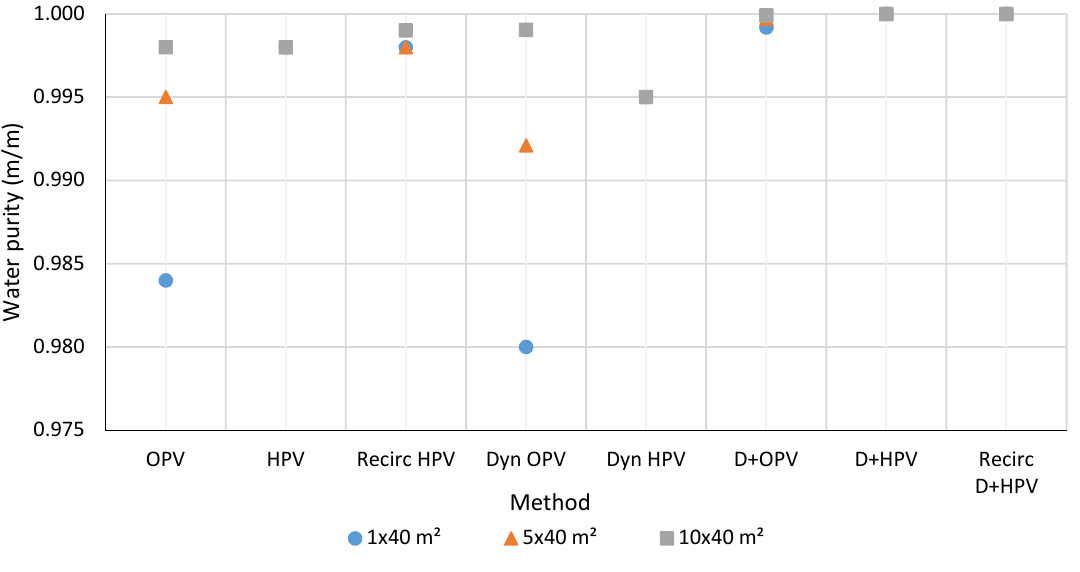
Membranes 2020 , 10 , x FOR PEER REVIEW Figure 10. Comparison of the water purity of ethanol-water selection methods. Figure 10. Comparison of the water purity of ethanol-water selection methods.